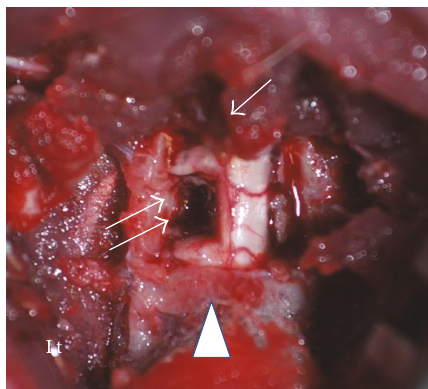
Figure 1: Macrographic image of the left C5 segmental hemisection of the cervical cord. Arrows: hemisected part; arrow: C2 spinous process; arrow head: C5 lamina; Lt: left.